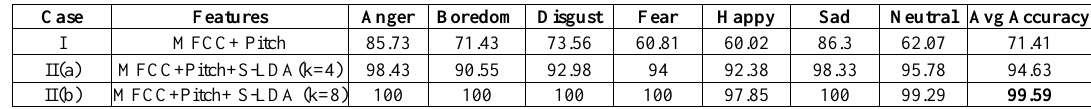
Table 2. AER for EMO-DB database using 1D-CNN Classifier.